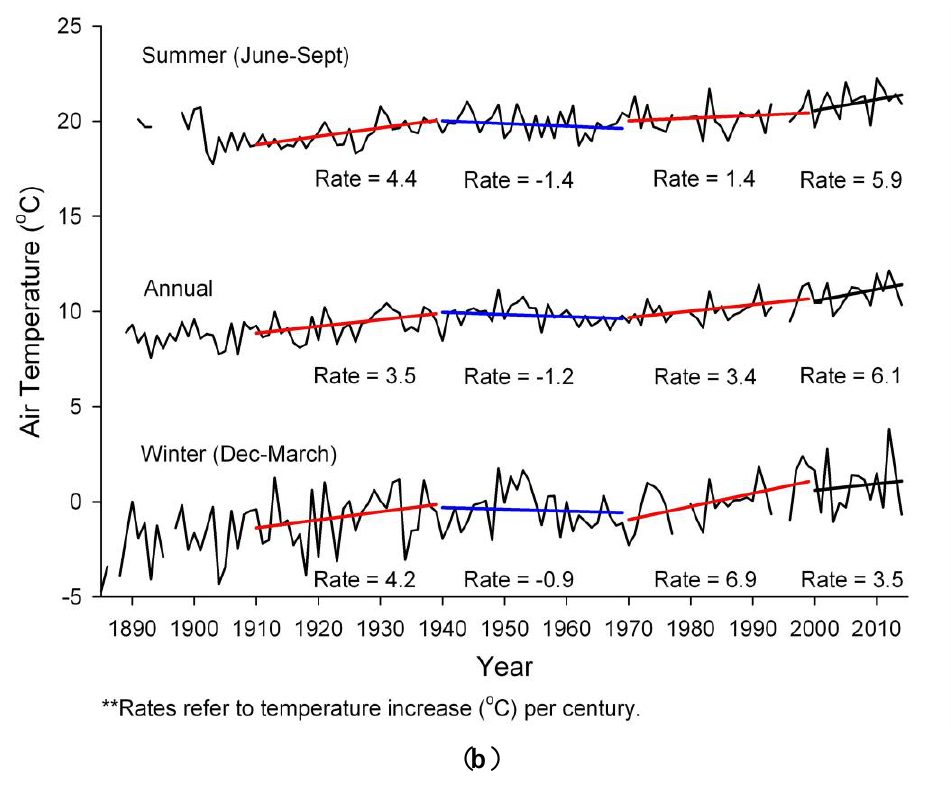
Figure 1. ( a ) Winter (December, January, February and March) NAO indices